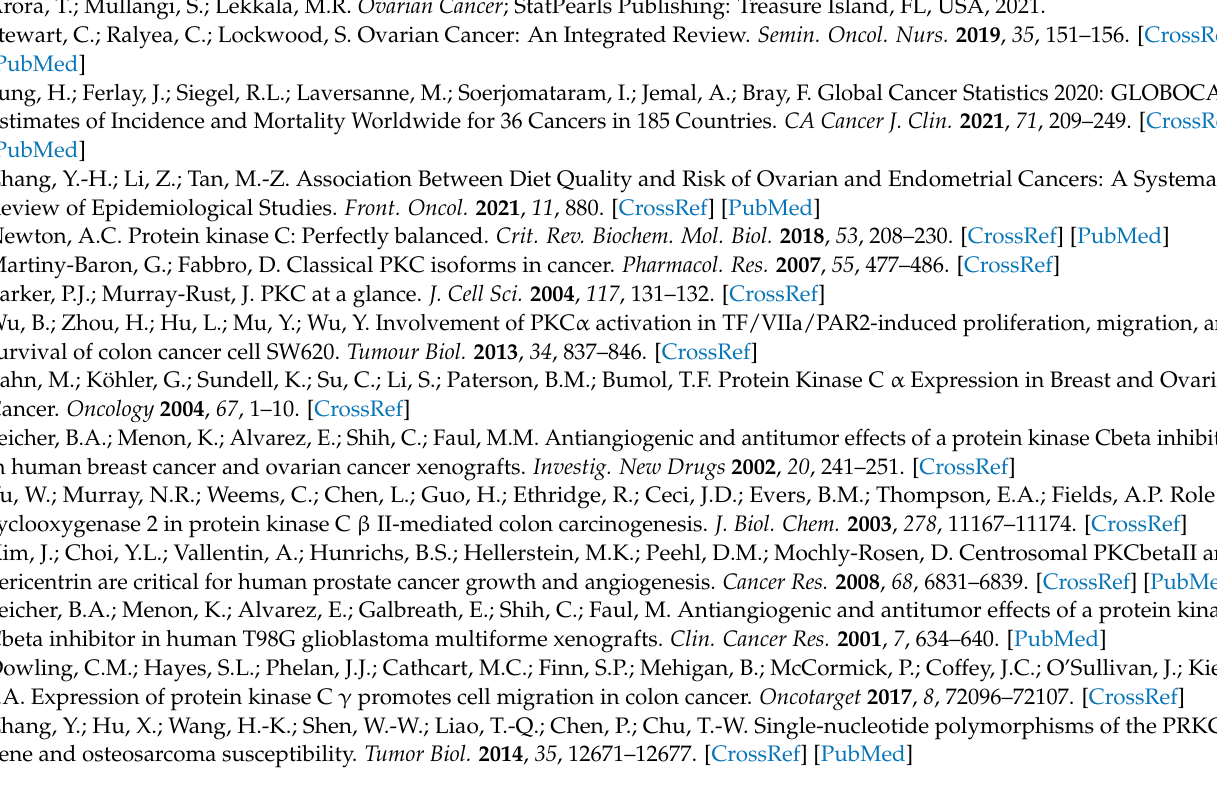
teins. Table S3: Data of each participant from diseased group regarding the clinical features along with Clinicopathological features. Table S4: Patient Consent Form. Table S5: Patient History Form. Table S6: Ethical approval